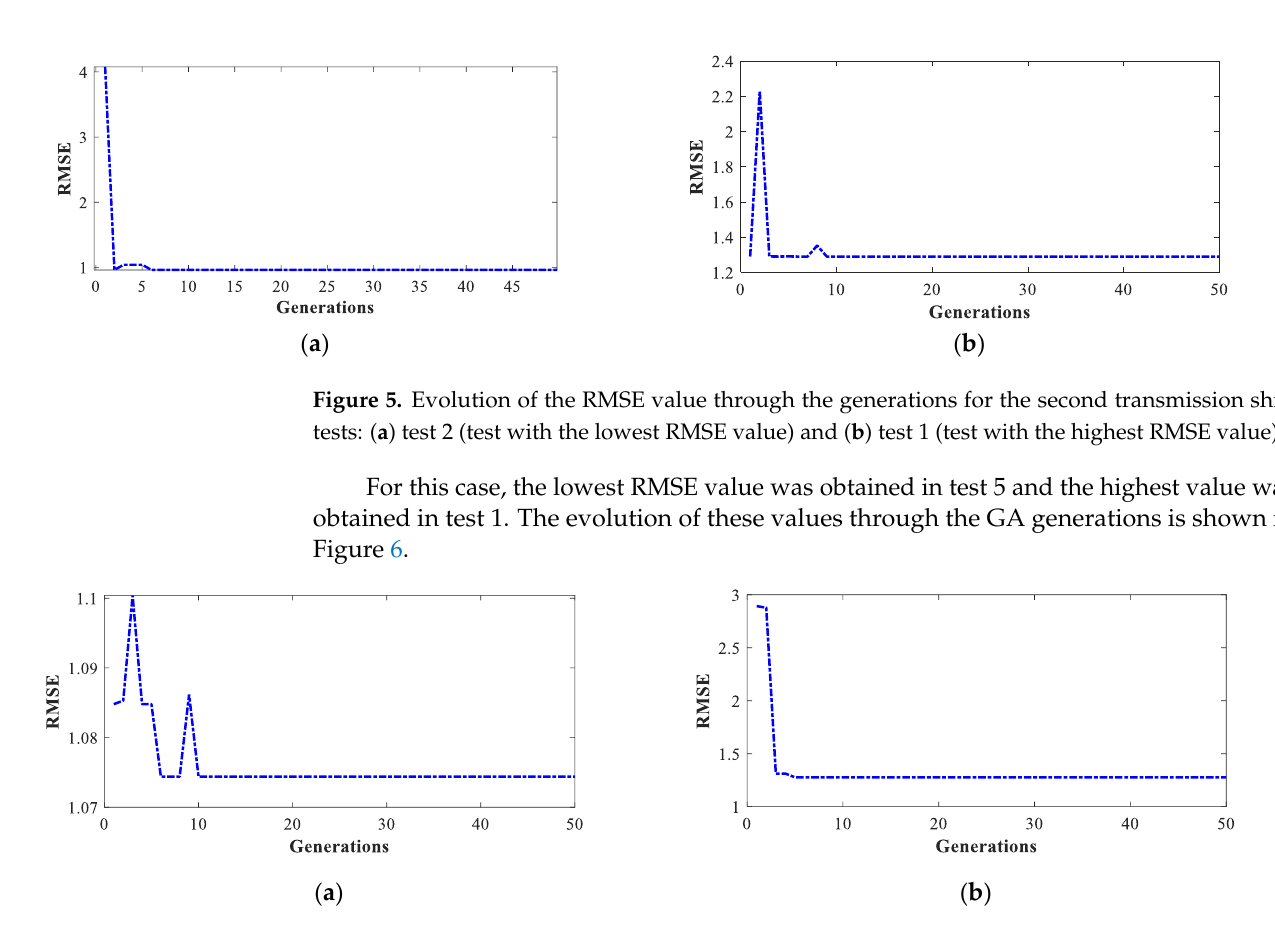
Figure 6. Evolution of the RMSE value through the generations for the third transmission shift tests: ( a ) test 5 (test with the lowest RMSE value) and ( b ) test 1 (test with the highest RMSE